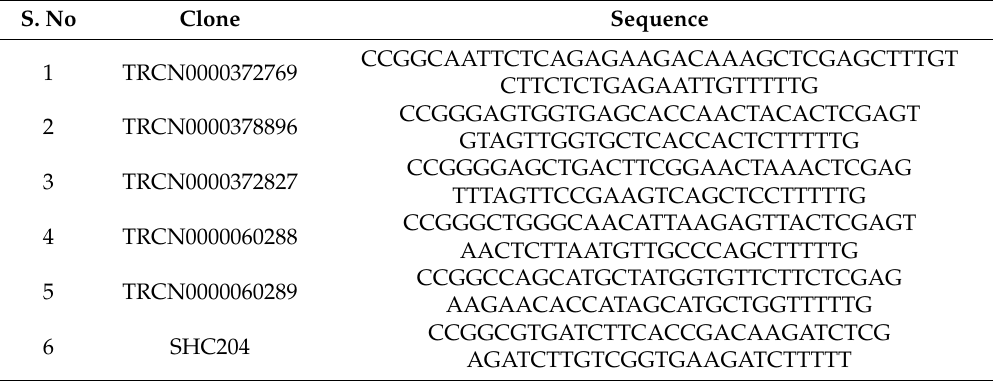
Table 1. Control shRNA (SHC204) and NGAL shRNA sequences used for transfection. S.